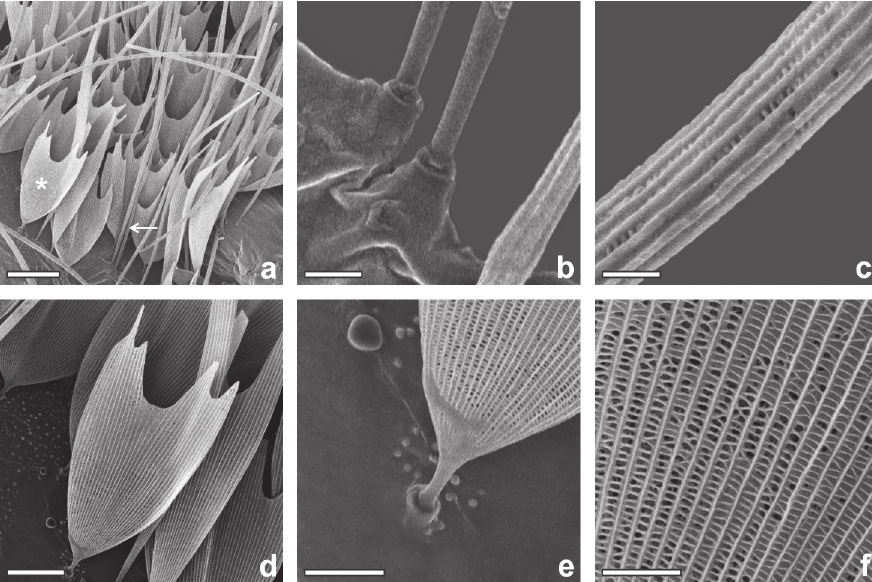
Figure 2 - Abdominal scales of the female H. oratex . (a) fi liform and spatulate scales, an arrow indicates fi liform and an asterisk indicates spatulate; (b) base of fi liform scale; (c) median portion of fi liform scale; (d) general view of spatulate scale; (e) base of spatulate scale; (f) medial portion of spatulate scale (scales = 100, 10, 5, 40, 20, 10 µm,